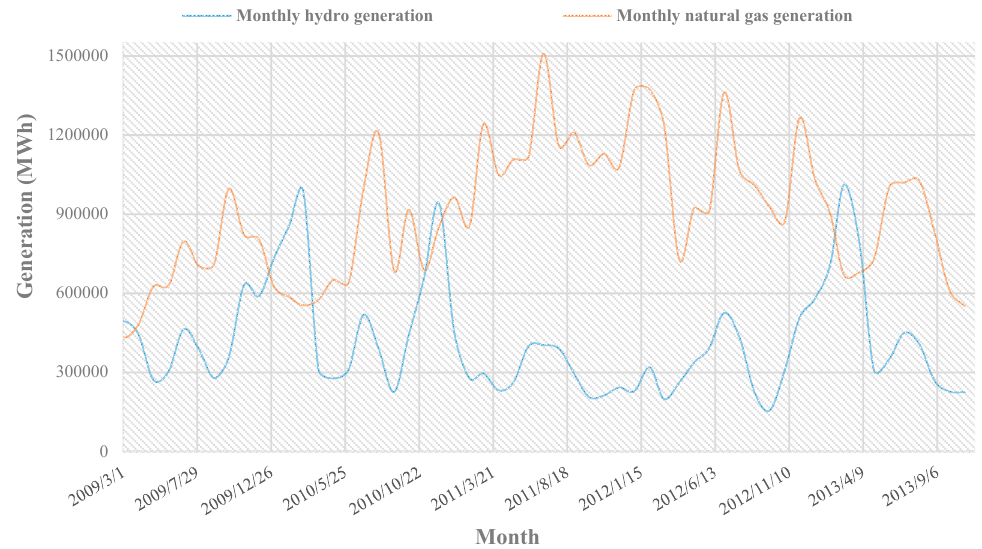
Figure 9. Monthly hydro and natural gas-fueled generation during the period March 2009 to September 2013 (data as acquired from [48]).